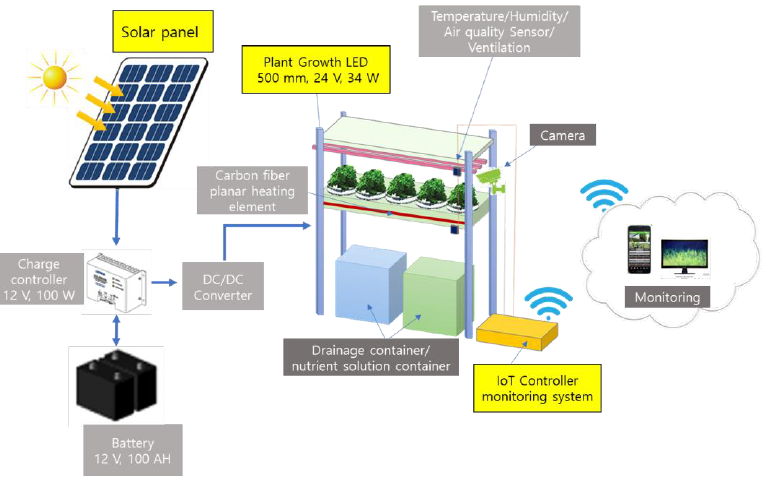
Figure 19. Proposed plant growth monitoring system.